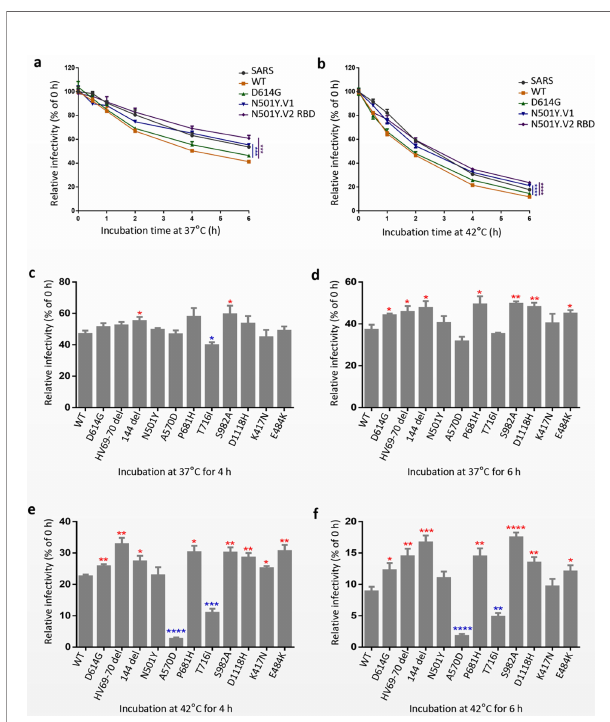
FIGURE 4 | SARS-CoV-2 variants N501Y.V1 and N501Y.V2 RBD are more thermal stable than WT and D614G. (A, B) SARS-CoV, SARS-CoV-2 WT, D614G, N501Y.V1 and N501Y.V2 RBD S pseudovirions were incubated in cell culture medium DMEM at 37°C (A) or 42°C (B) for the speci fi ed times (0 to 6 h). The viruses were quanti fi ed for their infectious levels by luciferase on 293T-hACE2 cells. The infection ef fi ciency of remaining viruses was normalized by the average fl uorescence values at 0h. (C – F) The single-site mutations of N501Y.V1 and N501Y.V2 RBD S pseudovirions were incubated in cell culture medium DMEM at 37°C for 4 h (C) and 6 h (D) or 42°C for 4 h (E) and 6 h (F) . The experiments were repeated twice, and means with SEM are shown. The signi fi cant changes were marked with colored symbols, red stars for increased, blue stars for decreased. ns represents no signi fi cant difference, p < 0.05 (*), p < 0.01 (**), p < 0.001 (***), p < 0.0001